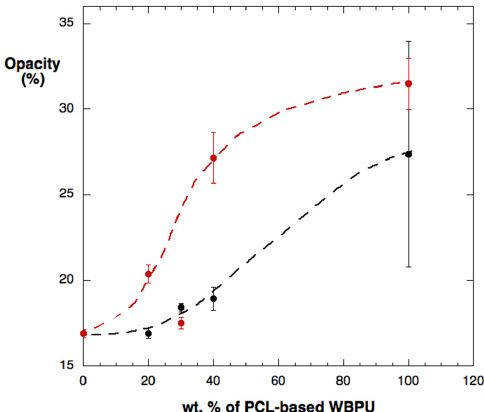
Figure 2. Opacity of the two sets of hybrid films: CO-TA/PCL-TA (black circles) and CO-TA/PCL- DMPA (red circles). Lines are drawn as guides to the eye.